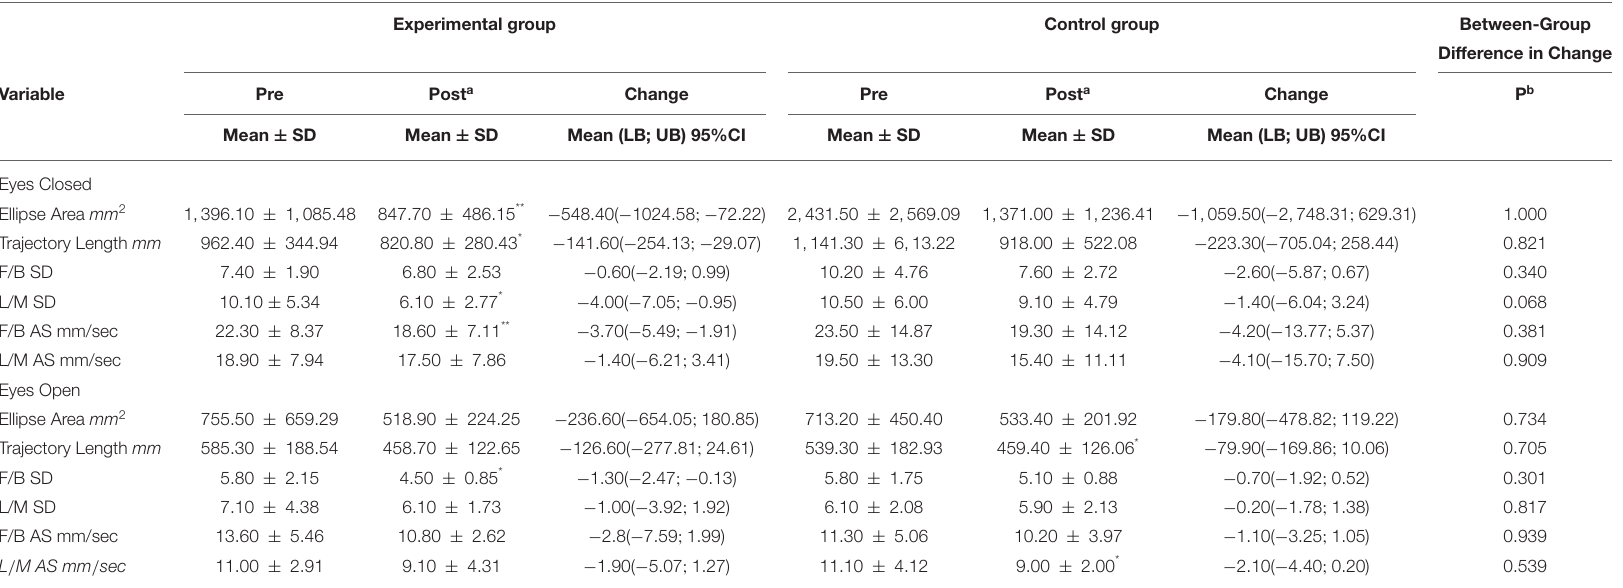
TABLE 4 | Pro-Kin balance test results at pre- and post-training between two groups. Experimental group Control group Between-Group